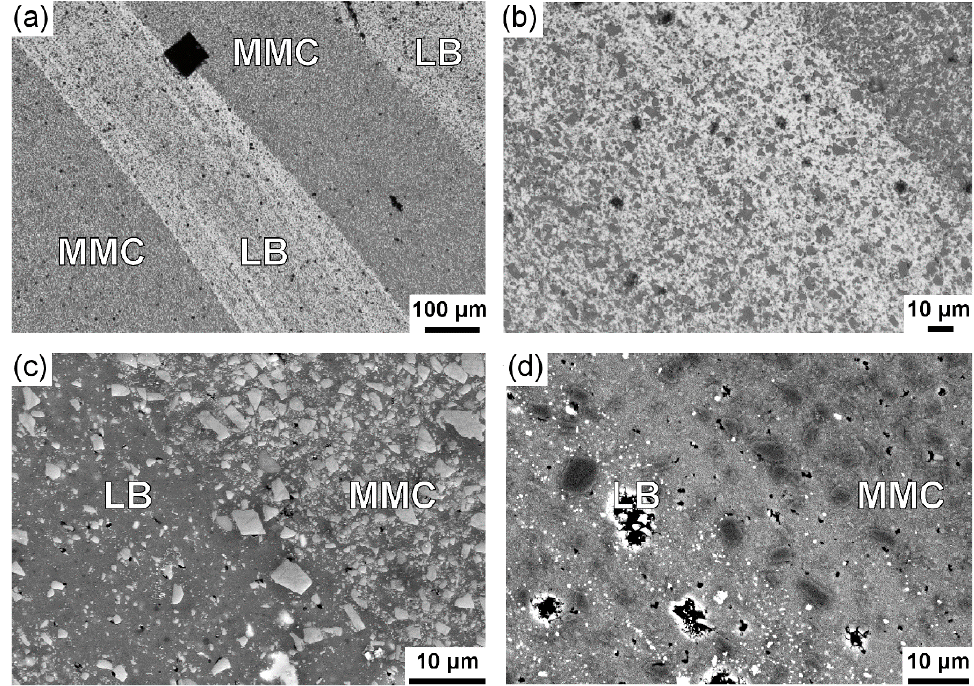
Figure 5. Images from region A in Figure 3b: ( a , b ) optical micrographs showing the layered bands (LB) on the MMC side at different magnifications. The dark rectangular feature in ( a ) is an indent produced during hardness measurements; ( c ) secondary electron image from a region along the LB/MMC interface; ( d ) BSE image from another region along the LB/MMC interface. In this BSE image, ceramic SiC particles appear dark, while Fe-rich intermetallic particles appear bright due to atomic number contrast.